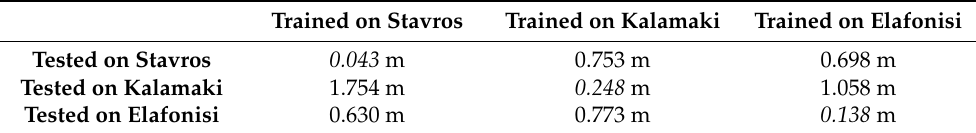
Table 5. RMSE values from cross-validation of individual area CNN models. Same area validation (italics). Trained on Stavros Trained on Kalamaki Trained on Elafonisi Tested on Stavros 0.043 m Tested on